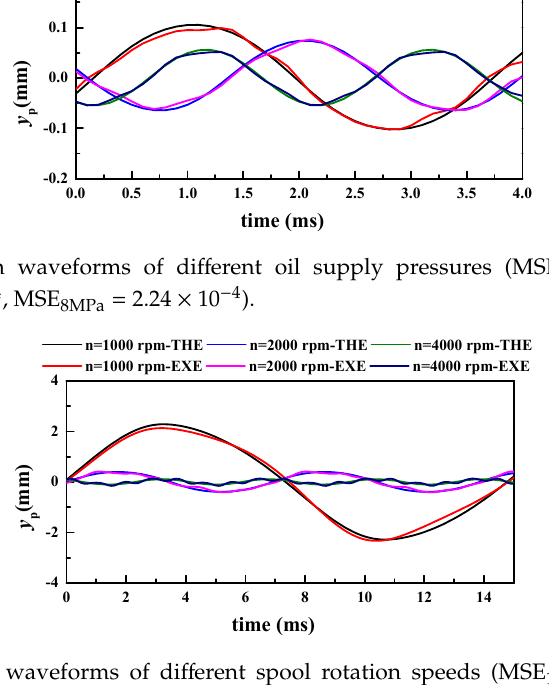
Figure 42. Vibration waveforms of different spool rotation speeds (MSE 1000rpm = 1.57 × 10 −3 , MSE 2000rpm = 1.87 × 10 −4 , MSE 4000rpm = 1.69 × 10 −4 ).